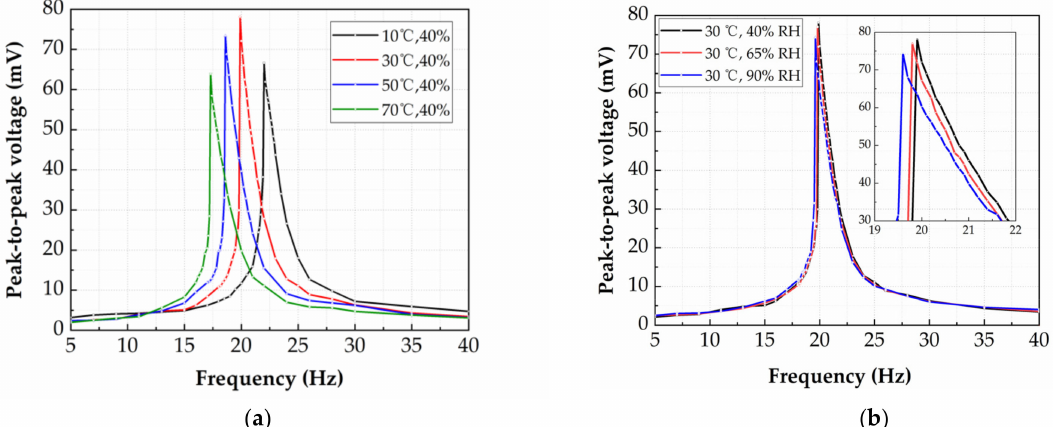
Figure 12. ( a ) The influence of temperature on the output voltage and resonant frequency of the energy harvester. ( b ) The influence of humidity on the output voltage and resonant frequency of the energy